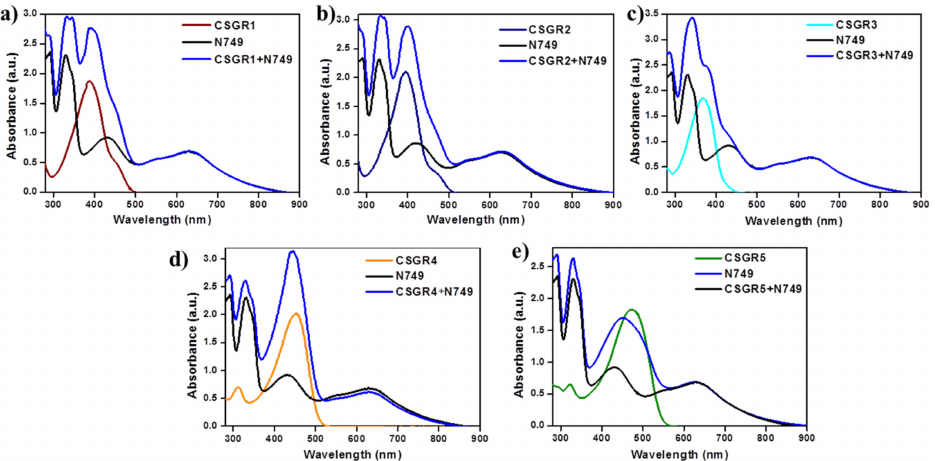
Figure 4. ( a–e ) are comparative absorption spectra of CSGR (0.05 mm), N749 (0.1 mm) and mixture of N749 and CSGR1-5 dyes (0.1 and 0.05 mm) in